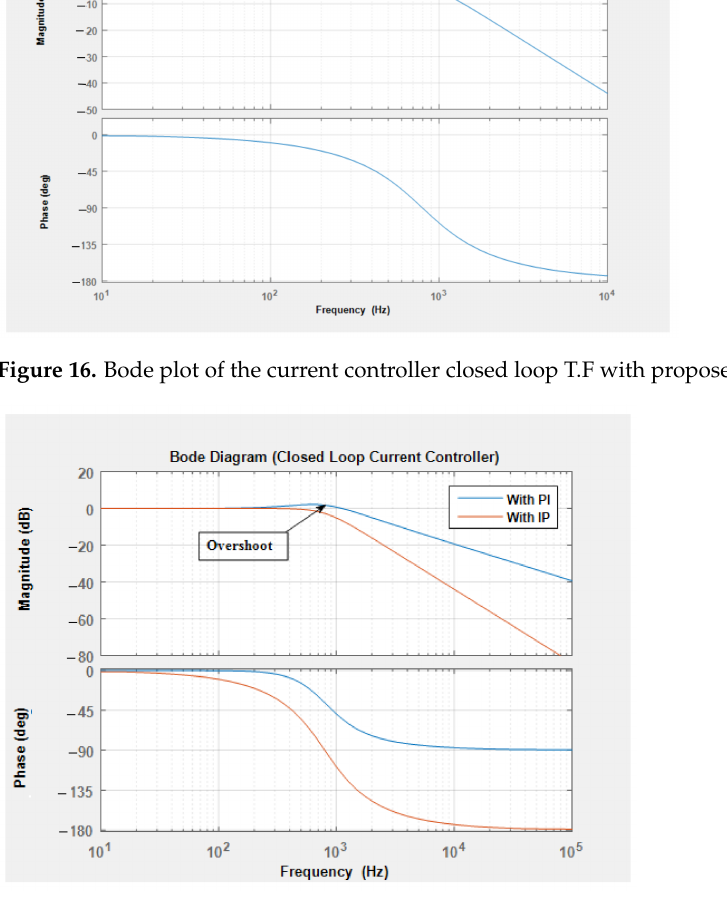
Figure 17. Bode plot of the inner current control loop with different